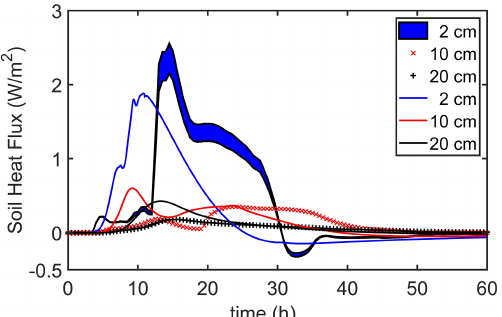
Figure 9. Soil heat flux during the 26 April 2004 MEF burn, with modeled (solid lines) and observed (blue color-filled area and red and black symbols) measurements. The upper boundary of the (2cm) blue color-filled region is the heat flux measured by the heat flux plate without the Philip correction (Philip, 1961). The lower boundary of this region is the measured heat flux after applying the Philip correction. The Philip correction is not shown for the two lower heat flux measurements because it made virtually no differ- ence to these measurements.